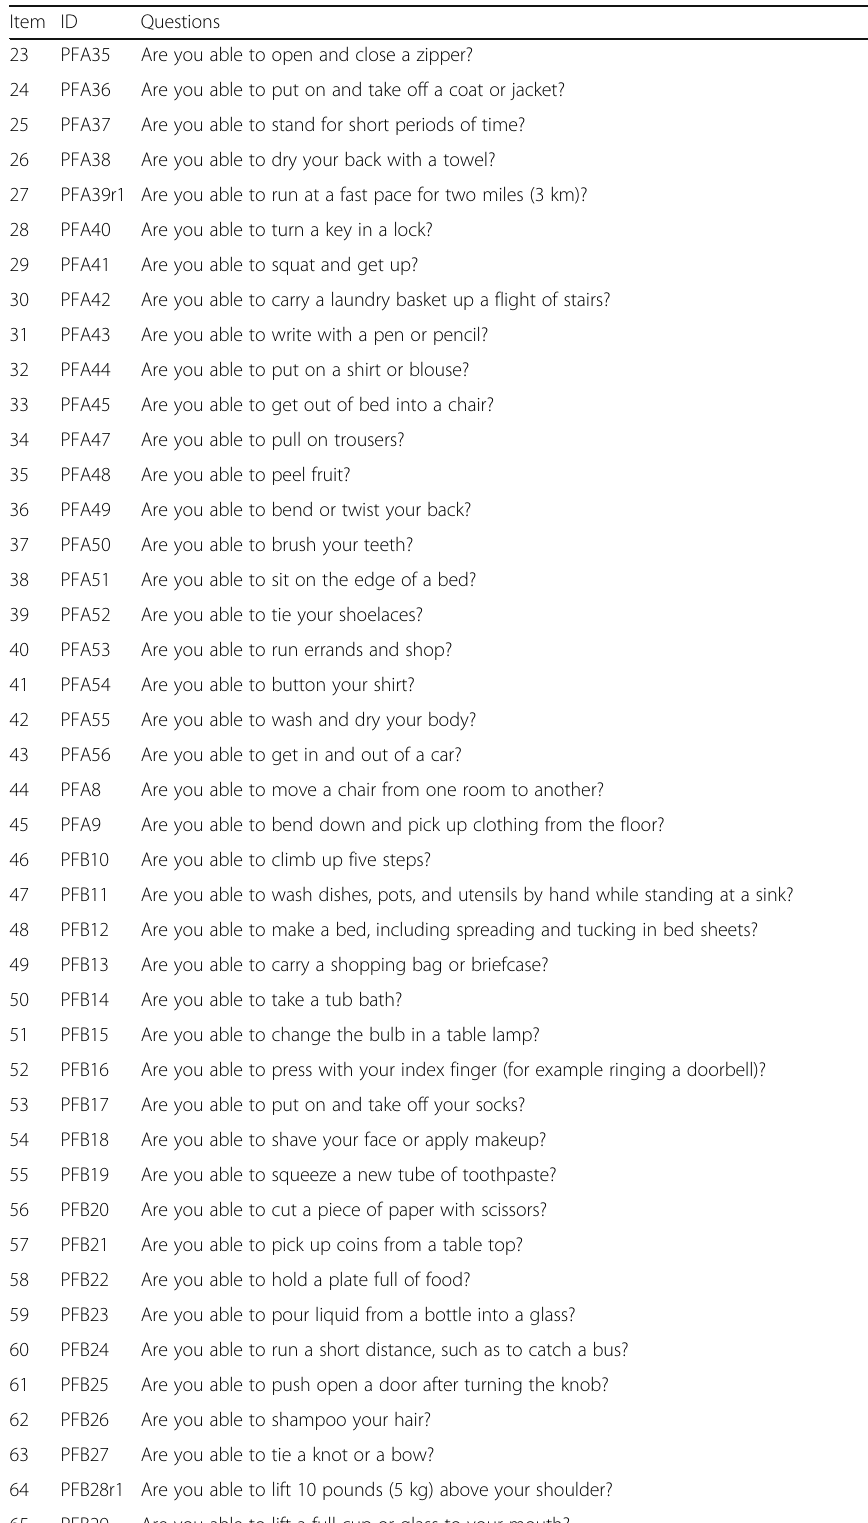
Table 5 PROMIS v1.2 Physical Function item bank